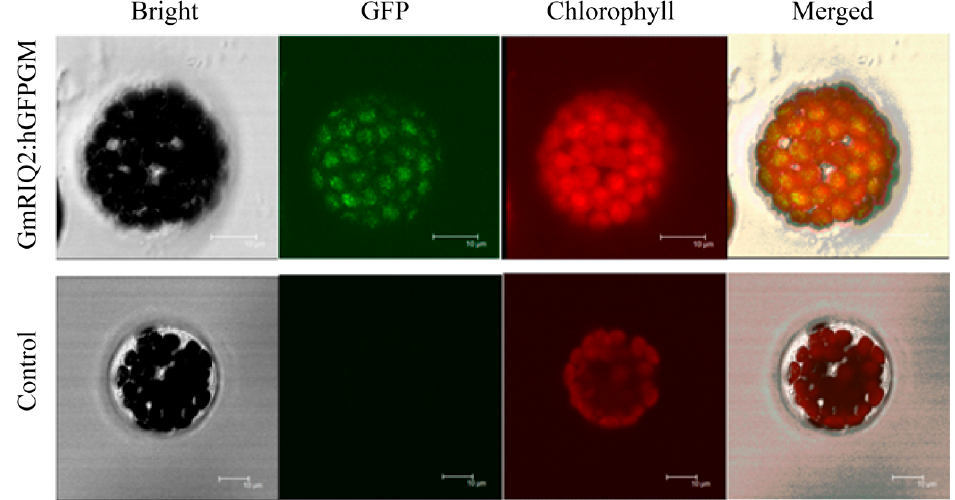
Figure 2. The subcellular localization of GmRIQ2-like was investigated in Arabidopsis protoplasts under a confocal microscope. The fl uorescent distribution of control and fusion proteins of GmRIQ2- a confocal microscope. The fluorescent distribution of control and fusion proteins of GmRIQ2-like –GFP like –GFP were observed under white, UV, and red light. Bars = 10 µm. were observed under white, UV, and red light. Bars = 10 µ